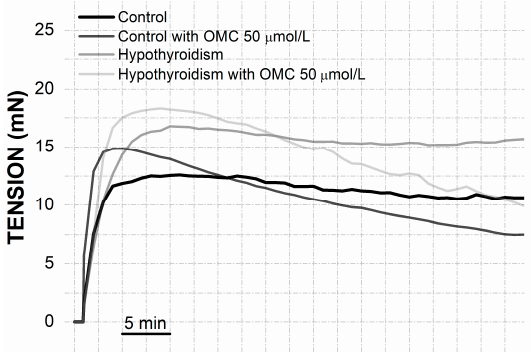
Figure 2. Real tension (mN) of the human umbilical artery (HUA)-rings without (control) and with hypothyroidism incubated with octylmethoxycinnamate (OMC, 0 and 50 µmol/L) and contracted by histamine (His; 10 µmol/L).